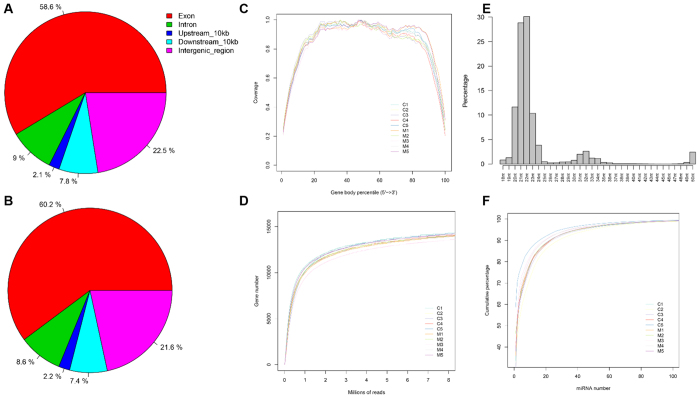
Quality control of RNA-Seq dataset.(A) The distribution of genomic locations of RNA-Seq reads in control compartment. (B) The distribution of genomic locations of RNA-Seq reads in infected compartment. (C) The plot of RNA-Seq coverage of gene body. (D) Saturation curve for gene number detection; X-axis - number of the mapped reads; Y-axis - number of the expressed genes (FPM> 1). (E) Length distribution of small RNA reads. (F) Cumulative frequency of detected miRNAs.